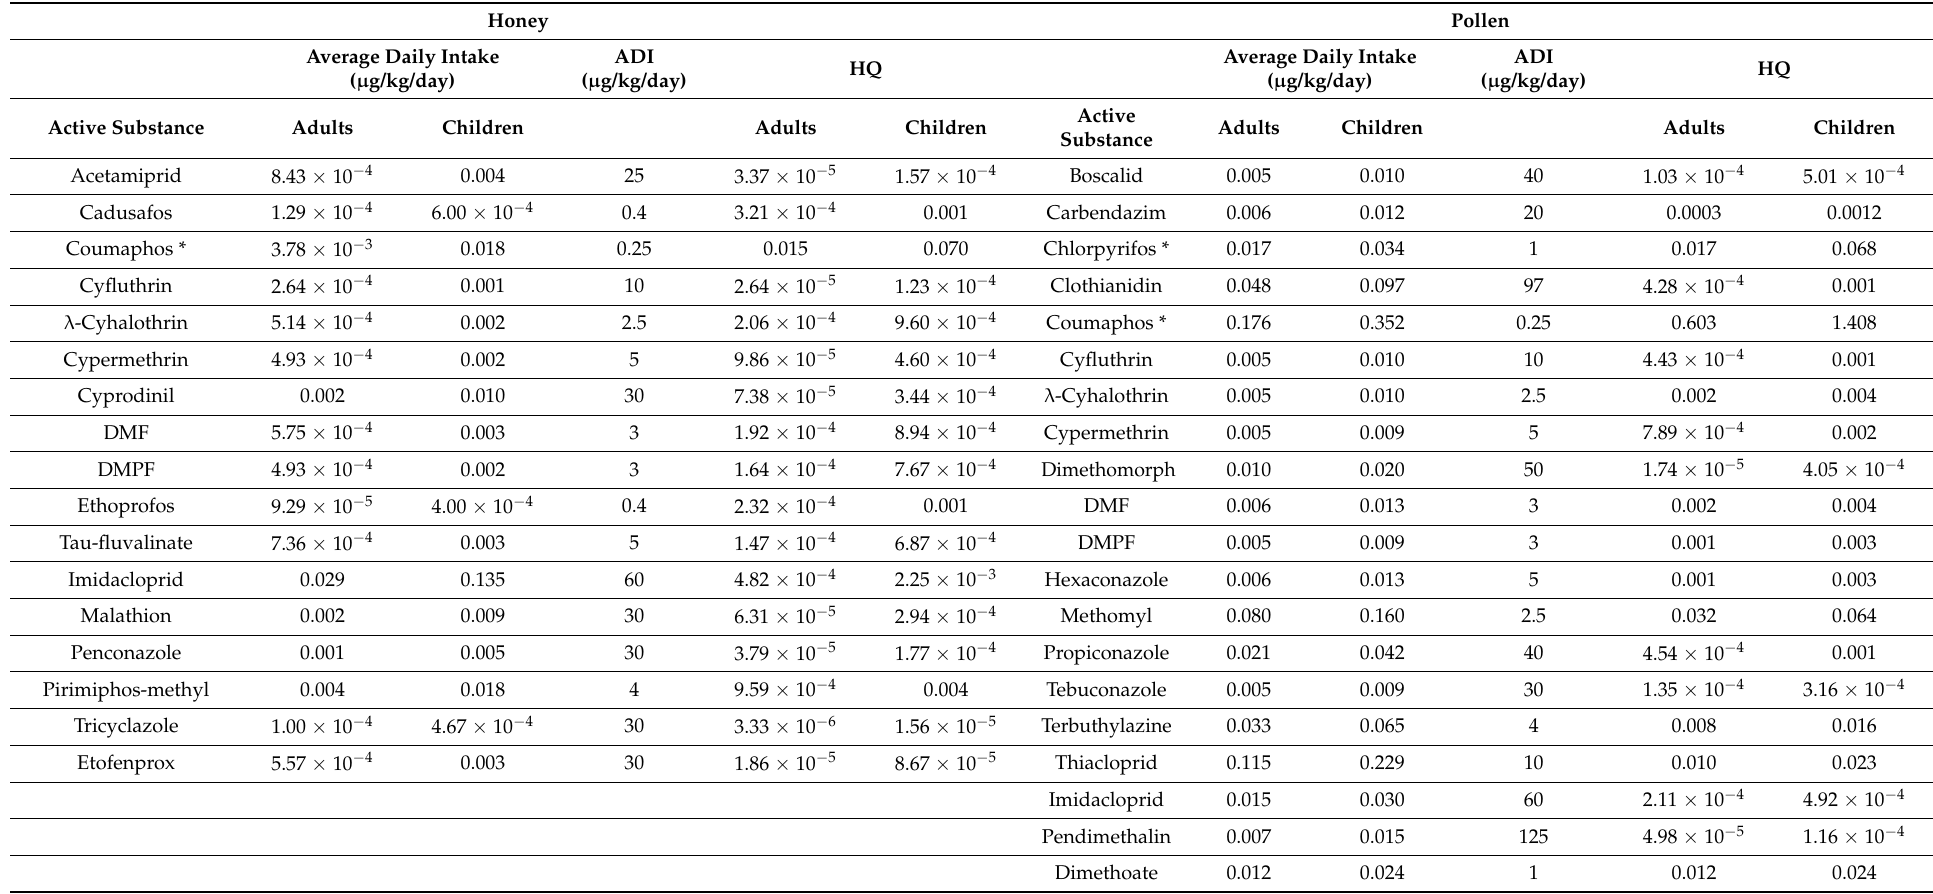
Table 3. Human health risk assessment for honey and pollen